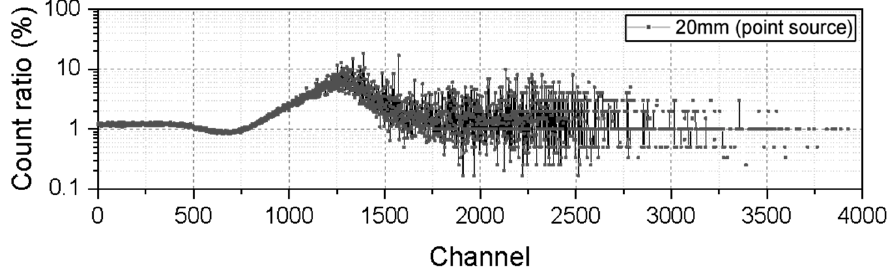
Figure 10. Count ratio from gamma spectra from a functional plastic scintillator.